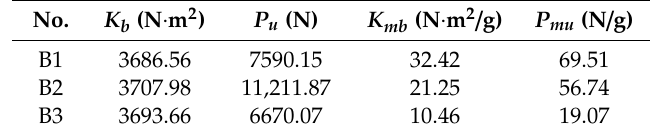
Table 2. Bending experiment data of the composite sandwich laminated box beams.